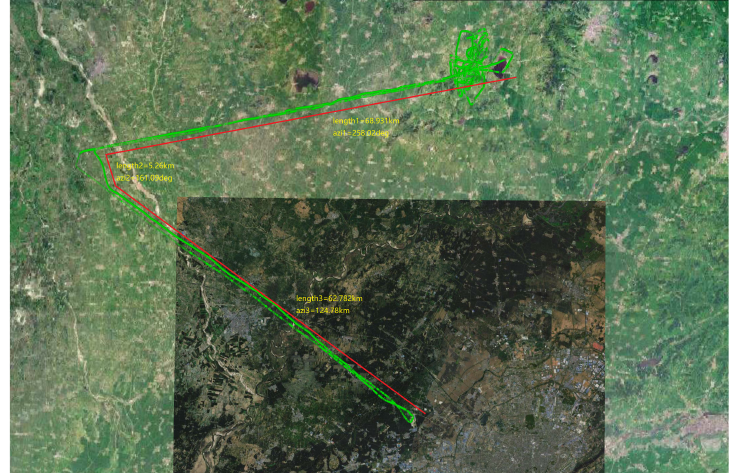
Figure 19. Flight trajectory of test-III. The green line is the trajectory, while the flight distance and azimuth are marked by the red line and the yellow text.